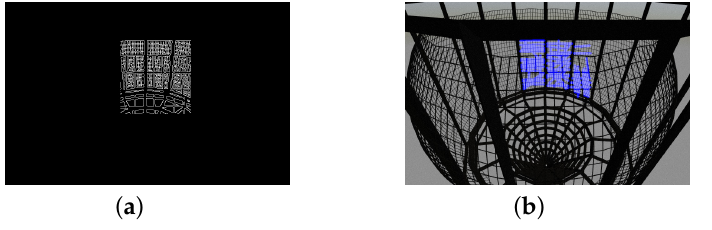
Figure 4. Output images after applying Canny edge detector: ( a ) detected edges in ROI; ( b ) resulted